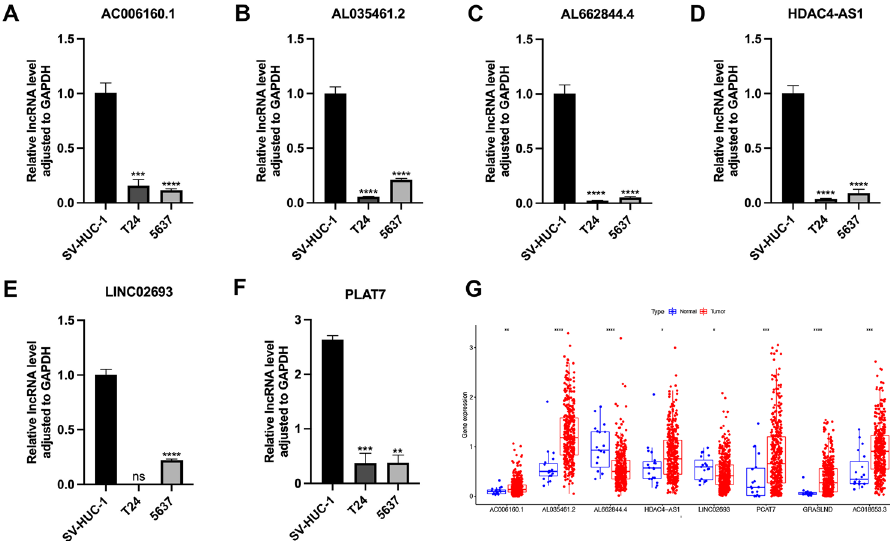
Figure 9. Relative expression of lncRNAs. ( A ) AC006160.1 ( B ) AL035461.2 ( C ) AL662844.4 ( D ) HDAC4-AS1 ( E ) LINCO2693 ( F ) PLAT7 expression in normal (SV-HUC-1) and BC cell lines. ( G ) Heatmap of lncRNAs expression in TCGA. * P < 0.05; ** P < 0.01; *** P < 0.001; **** P <